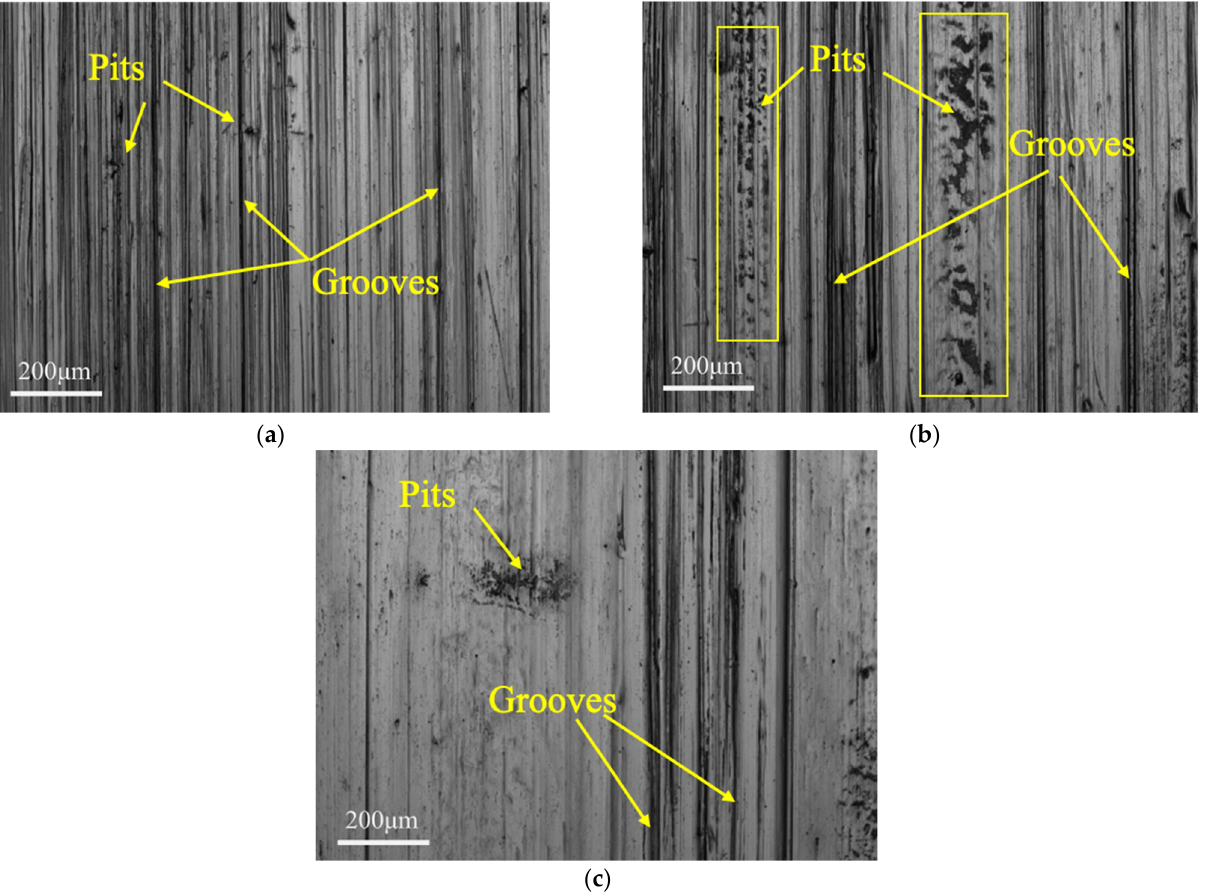
Figure 6. SEM images in the middle area on the sample surfaces after the wear test with slurries containing 20 wt.% of a soft abrasive: ( a ) talc, ( b ) dolomite and ( c ) fluorite. containing 20 wt.% of a soft abrasive: ( a ) talc, ( b ) dolomite and ( c )